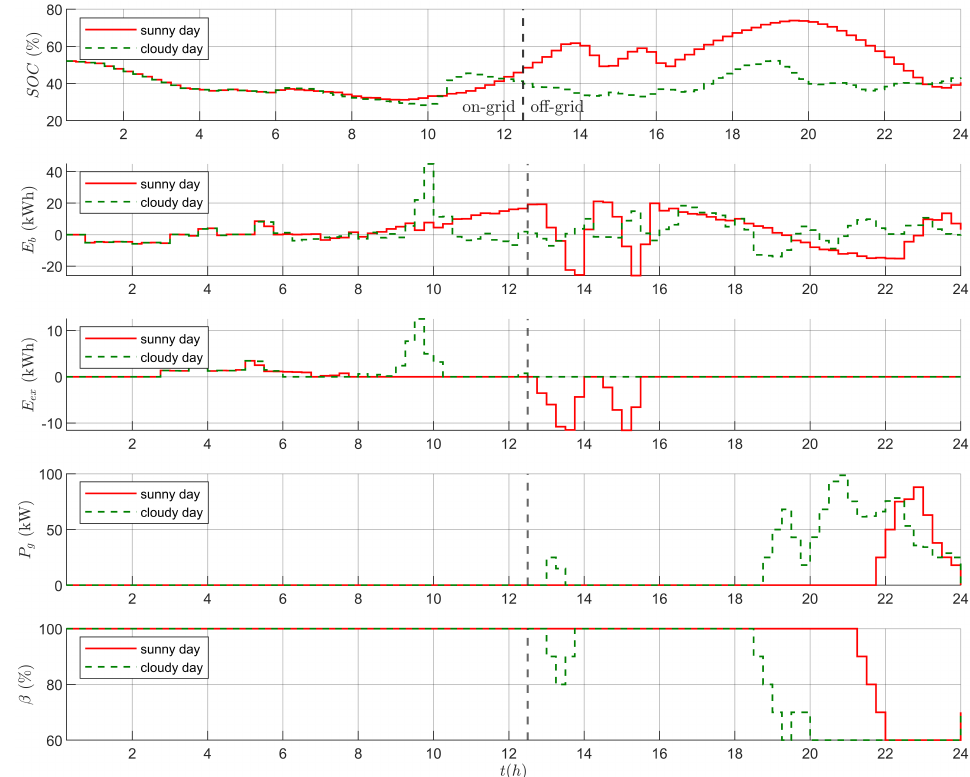
Figure 7. Storage state of charge, energy balance and all system inputs over a 24-h simulation period of the sunny and cloudy